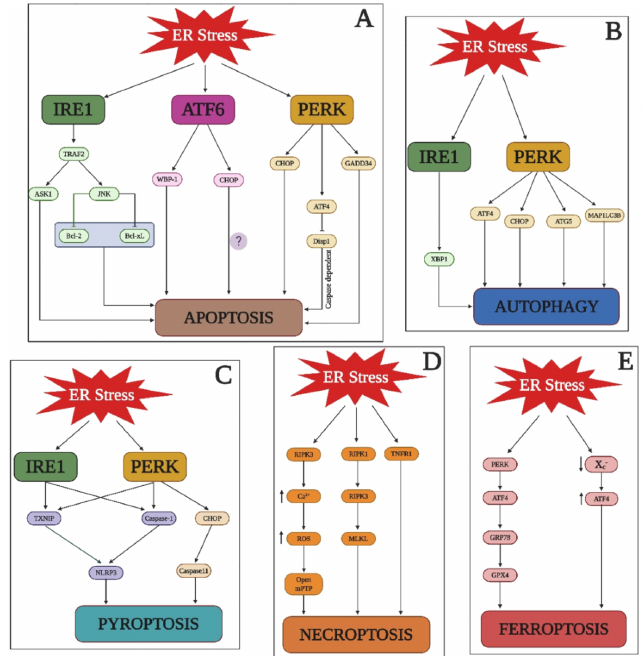
Figure 5. ER stress and cell death. A depiction of ER stress related signal transduction pathways that is responsible for apoptosis, autophagy, pyroptosis, necroptosis, and ferroptosis.